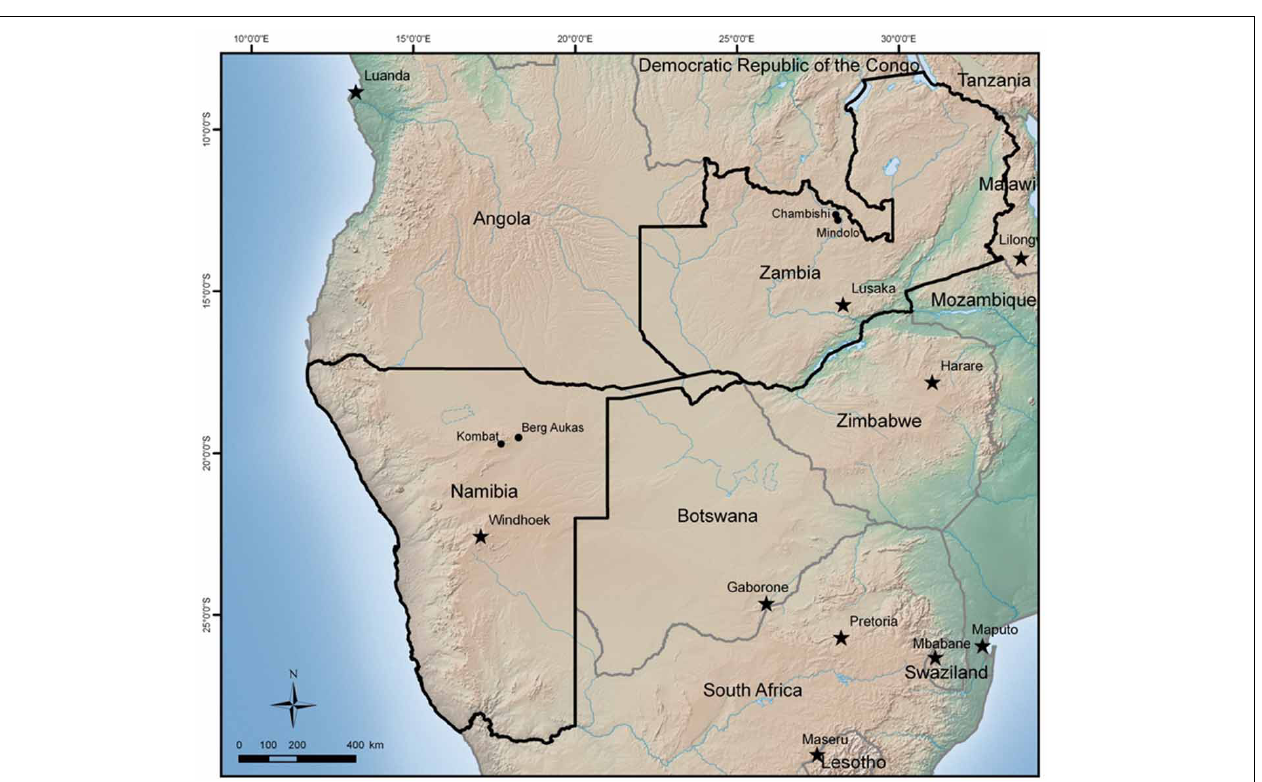
FIGURE 1 | Location of mine tailings in Zambia and